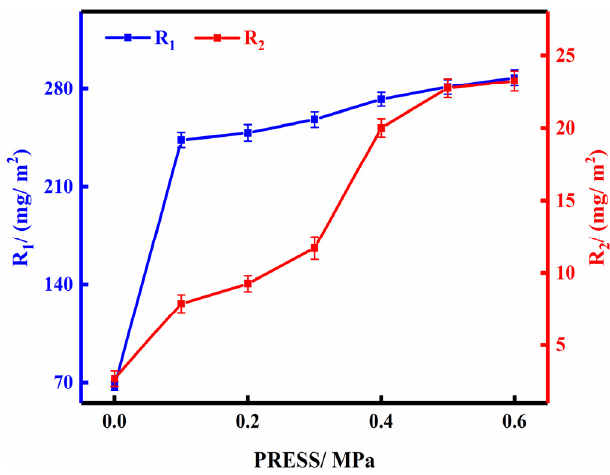
Figure 4. The effect of pressure on drug loading of bamboo strips.